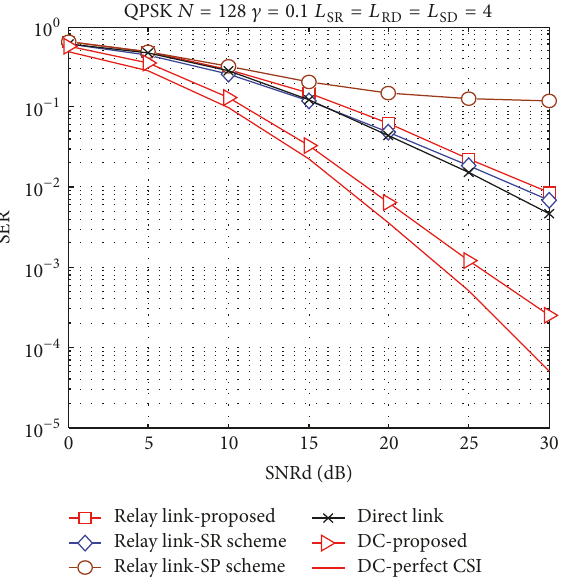
Figure 3: NMSE performance versus power-allocation factor at the relay.